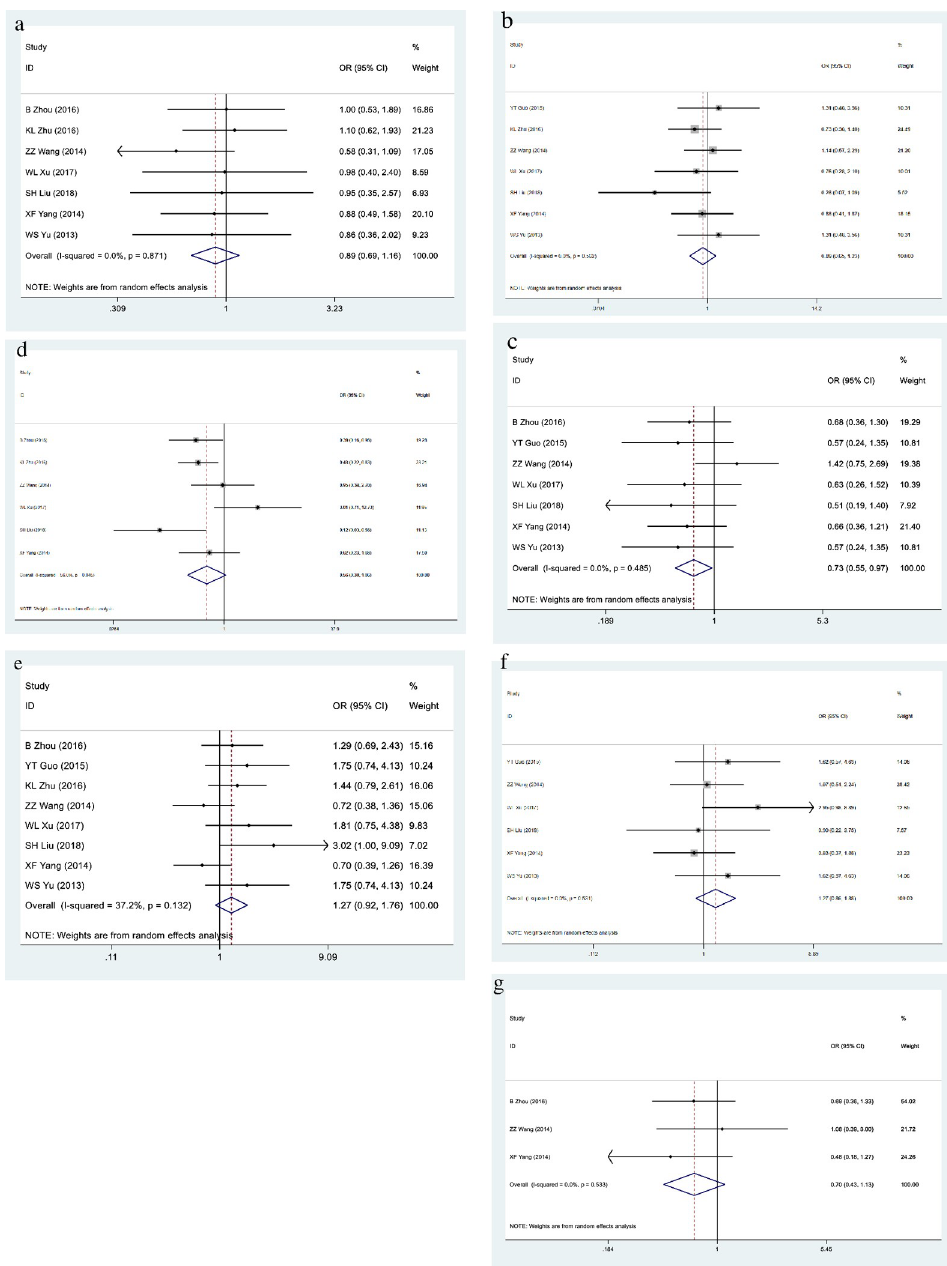
Fig 3. The forest plot of ORs was assessed for association between GOLPH3 and clinicopathological parameter outcome. a: gender (male vs female); b: age ( < cut-off vs � cut-off); c: tumor stage (stage I/II vs stage III/IV); d: tumor differentiation (well differentiation vs moderate to poor differentiation); e: lymphatic metastasis (with lymphatic metastasis vs. without lymphatic metastasis); f: tumor size ( < cut-off vs � cut-off); g: T stage (T1/2 vs T3/4). The horizontal line represents the range in which the truth value of the study exists. The dots on the horizontal line represent the effect size of a single study, and the size of the dots represents the weight. Diamonds represent the result of the